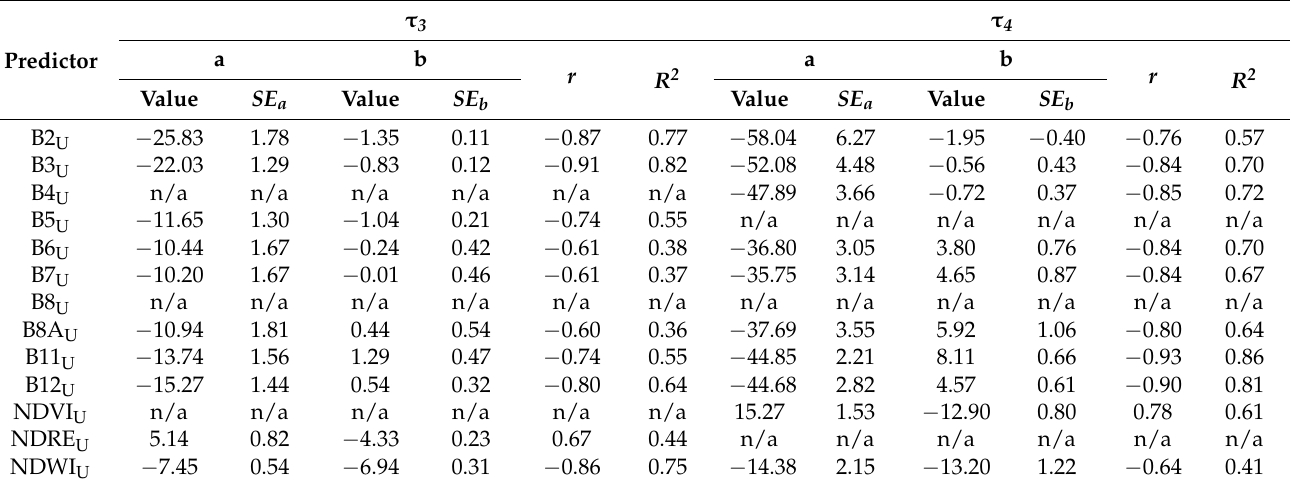
Table 7. Statistics concerning the ˆ τ 3 and ˆ τ 4 estimates by Equation (7). SE = standard error of the parameters, r = Pearson correlation coefficient, R 2 = coefficient of determination. Predictors are “pure” bands and spectral indices. B8, B4, B5, NDVI and NDRE were not considered (n/a).